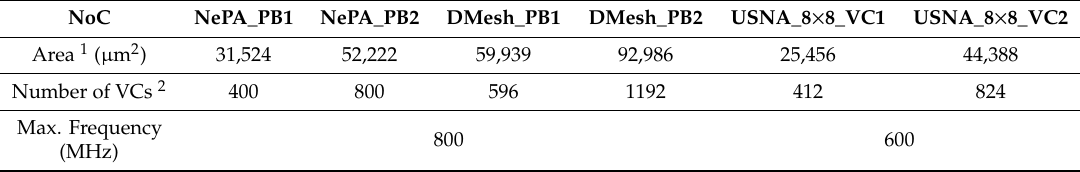
Table 3. Comparison of area and maximum